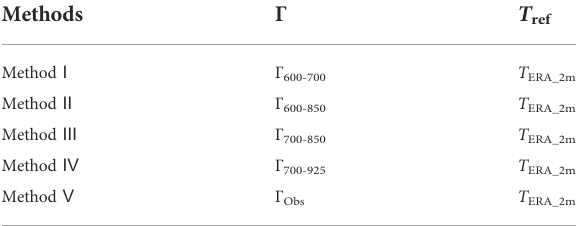
TABLE 2 Summary of Γ and T ref used in fi ve correction methods for 24 test